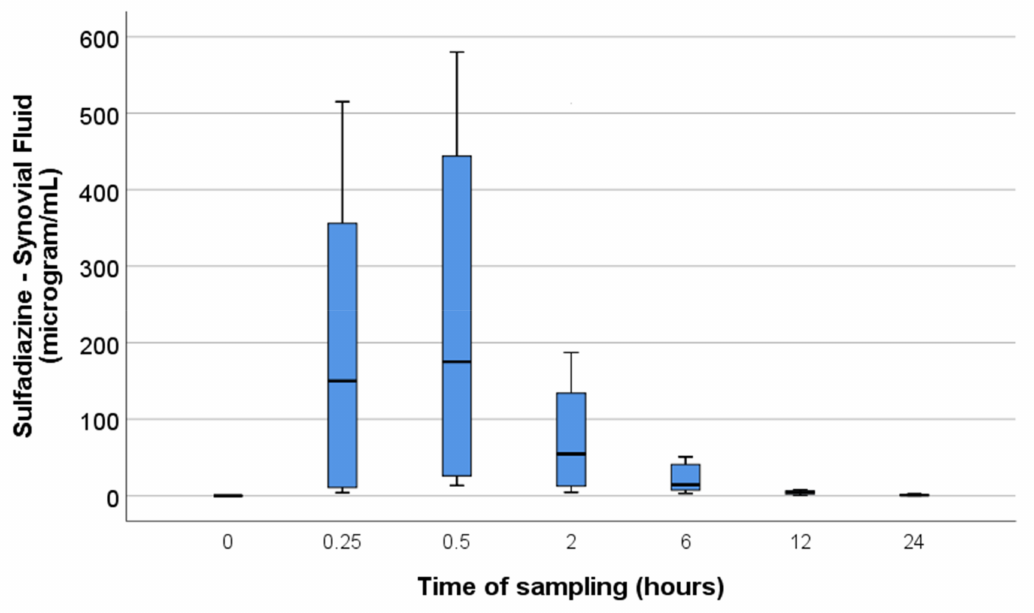
Figure 2. Sulphadiazine synovial fluid concentrations at each time point. Median values and quartiles indicated by boxplots with maximum and minimum values indicated by whiskers. The synovial fluid concentrations were only significantly different from the concentrations at T0 at time points 0.25, 0.5 and 2 h, although the median synovial fluid concentration remained above the MIC (9.5 µ g/mL) until the 6-h time